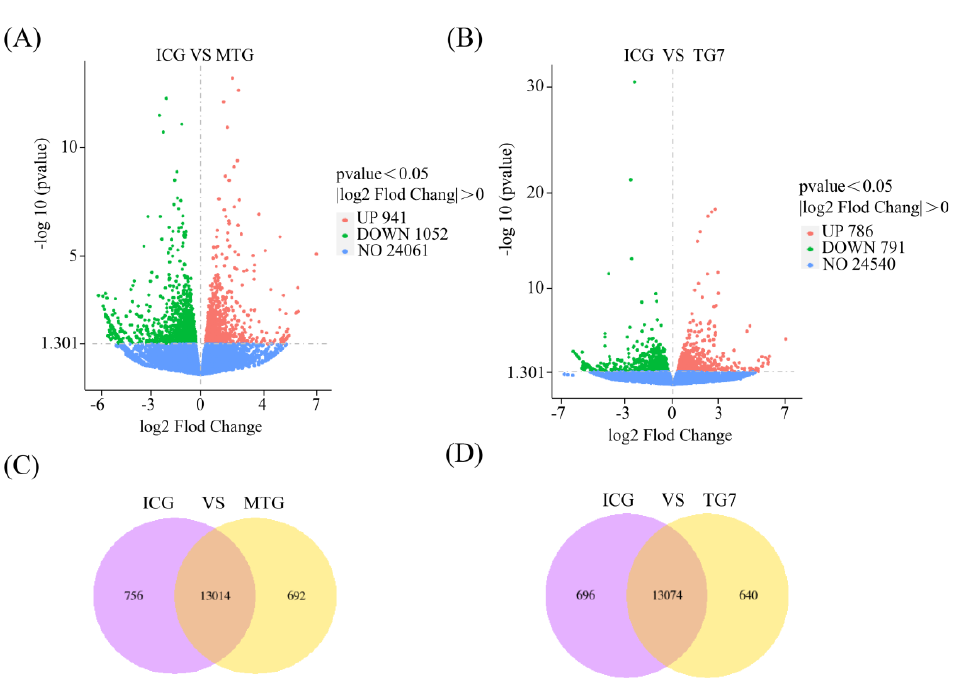
Figure 5. ( A , B ) Plots of DEGs volcanoes in MTG and TG7 compared with ICG. The horizontal coordinates indicated fold change of gene expression in the treated and control groups (log2 Fold Change), while the vertical coordinates indicated the significance level of DEGs in the treated and control groups ( − log10 p value). Genes with obvious upward calls were indicated by red dots, genes with obvious downward calls were indicated by green dots, and genes without obvious differential expression were indicated by blue dots. ( C , D ) Venn diagram of DEGs in MTG and TG7 compared with ICG. The sum of all numbers in circles represents total number of DEGs in this comparison combination, overlapping areas indicated the number of DEGs shared between combinations. Insomnia control group (ICG); Positive drug (melatonin) group (MTG); Tyr-Gly-Asn-Pro-Trp-Glu-Lys (TG7).